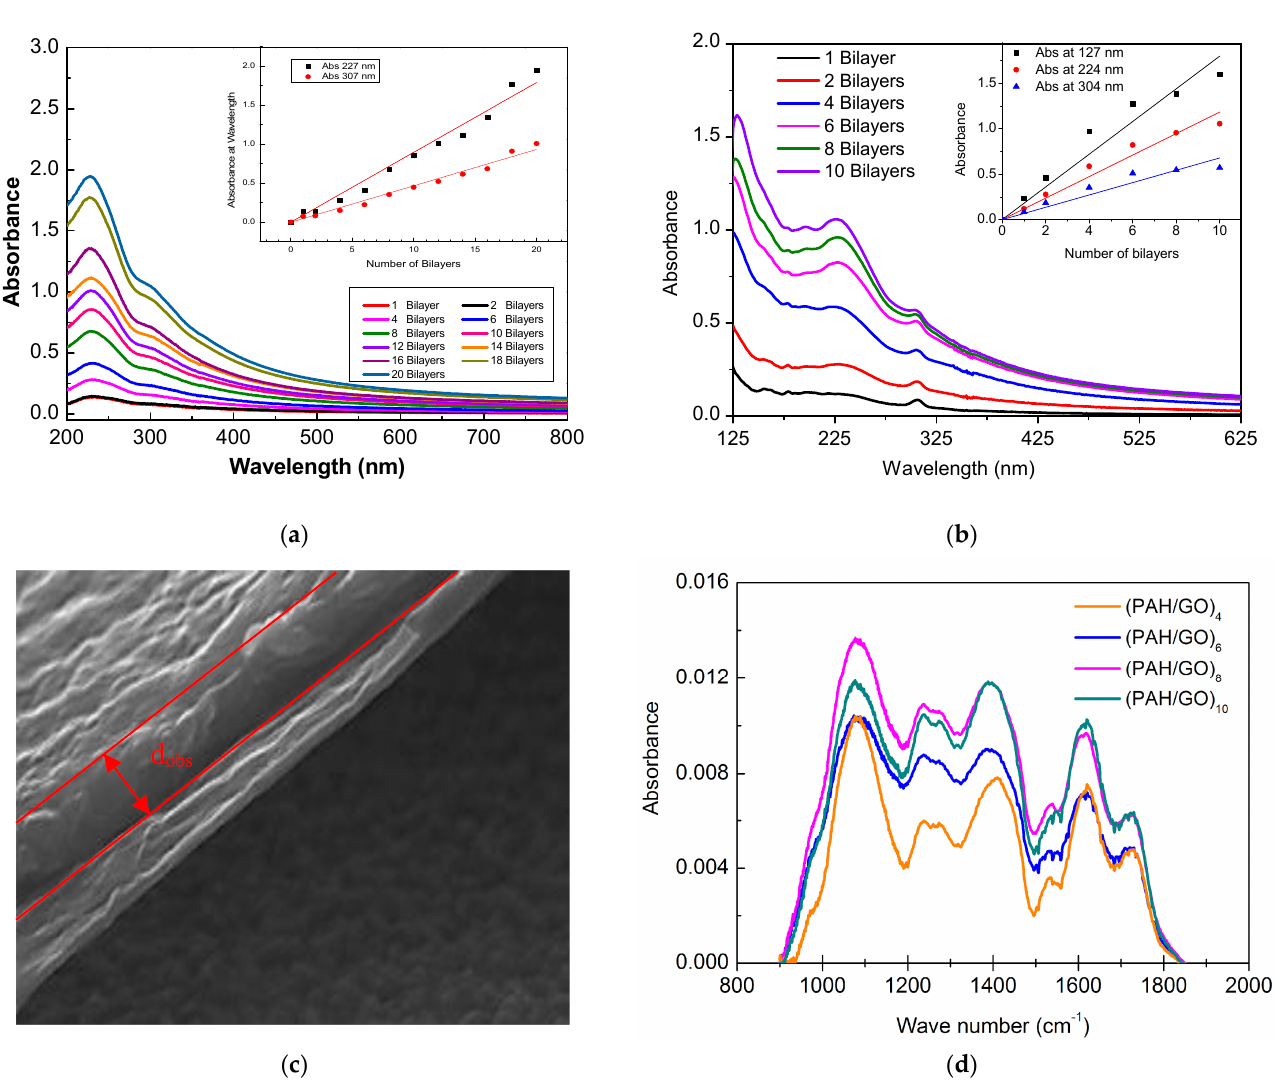
Figure 2. ( a ) UV-Vis absorption spectra for the different bilayers of a PAH/GO LbL film, prepared from aqueous solutions of PAH and GO with concentrations of 10 − 2 M. The inset shows the relation between the maximum absorbance at the bands, namely at 227 nm and 307 nm, as a function of the number of bilayers, n. ( b ) VUV absorption spectra for different bilayers of a PAH/GO LbL film deposited on CaF 2 substrates, up to a maximum of 10 bilayers. The inset the absorbance of bands at 127 nm, 224 nm and 304 nm as a function of the number of bilayers, n. ( c ) SEM cross-sectional image of the device developed with the FTO/(PAH/GO) 20 /Al configuration with the Al layer with a thickness of 270 ± 10 nm, indicated by d obs , deposited by thermal evaporation. The (PAH/GO) 20 film is the region between the Al layer and the dark region. ( d ) FTIR spectra of the growth of a PAH/GO film deposited on a CaF 2 substrate, with the measurements performed after the 4th, 6th, 8th and 10th bilayers.